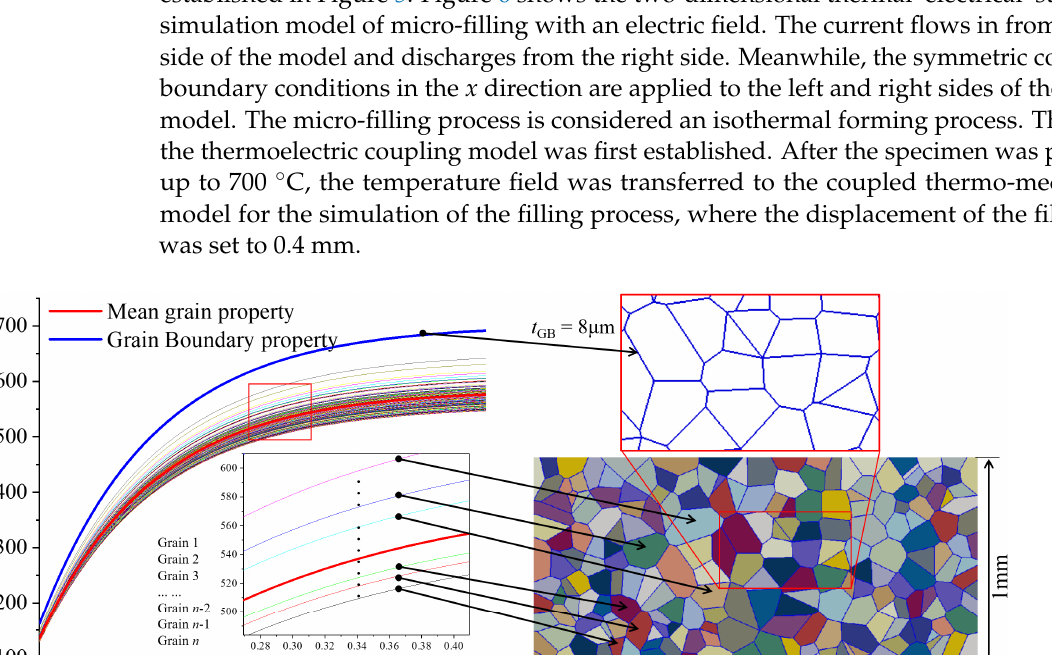
Figure 5. Polycrystal models of SUS304 stainless steel with different grain sizes: ( a ) 95 μ m; ( b ) 18.81 μ m. Figure 6. Two ‐ dimensional simulation finite element model of electrically assisted micro ‐ filling. 3. Results and Discussion 3.1. Constitutive Model Verification The experimental data of electrically assisted micro ‐ compression of SUS304 stainless steels are from Ref. [30]. The stainless steels with a grain size of 18.81 μ m and 95 μ m are chosen for model verification, and they are denoted as fine ‐ grained (FG) and coarse ‐ grained (CG) materials, respectively. The relationship between constitutive model parameters and current density is shown in Figure 7, where “Exp.” represents the experimental data and “Theo.” is the theoretical prediction value (the same below).